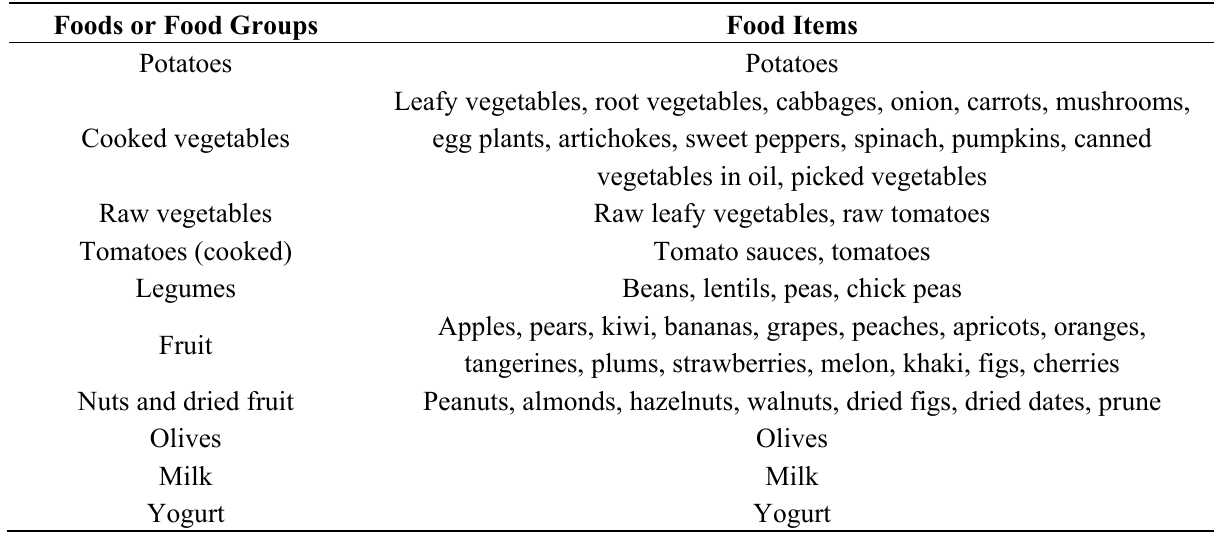
Table 1. Food grouping used in the dietary pattern